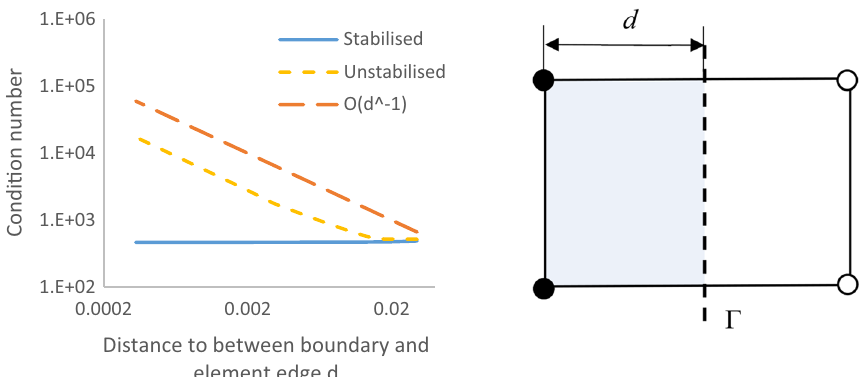
Fig. 10 Plot of the 2-norm condition number for different boundary locations and schematic showing unfitted boundary and distance to element edge